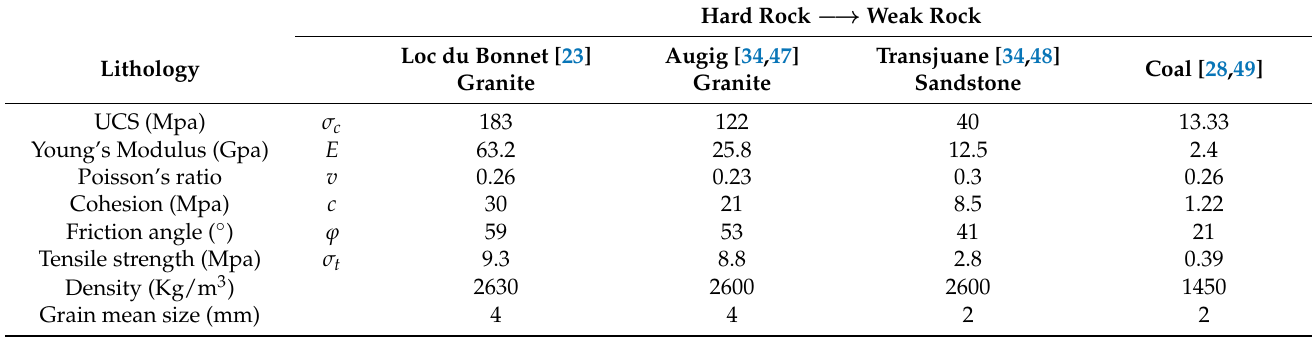
Table 2. Rock macro-properties (experiment